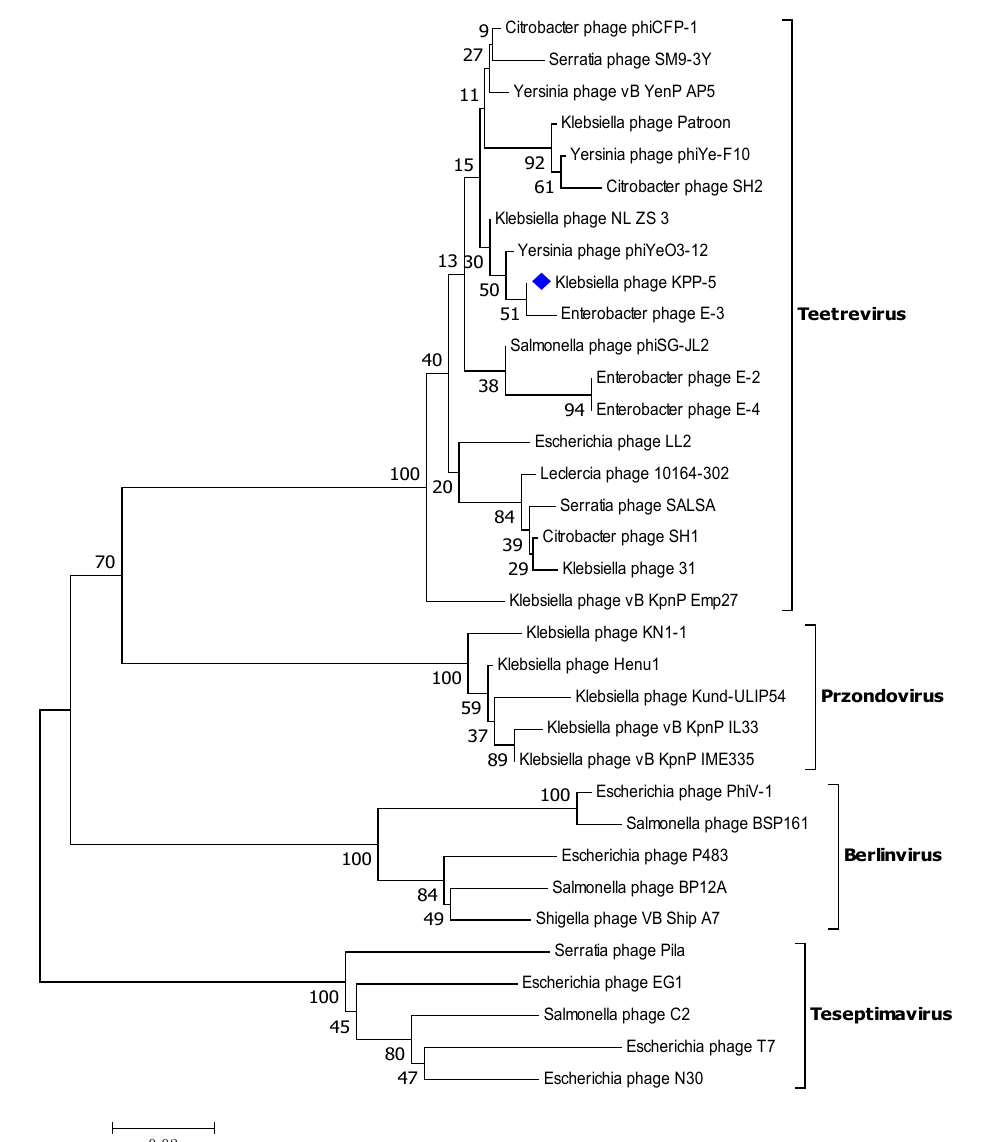
Figure 8. Neighbor-joining tree of Klebsiella phage KPP-5 compared to other phages available in GenBank based on the alignment of major capsid protein amino acid sequences. The numbers represent bootstrap percentage values based on 1000 replicates.